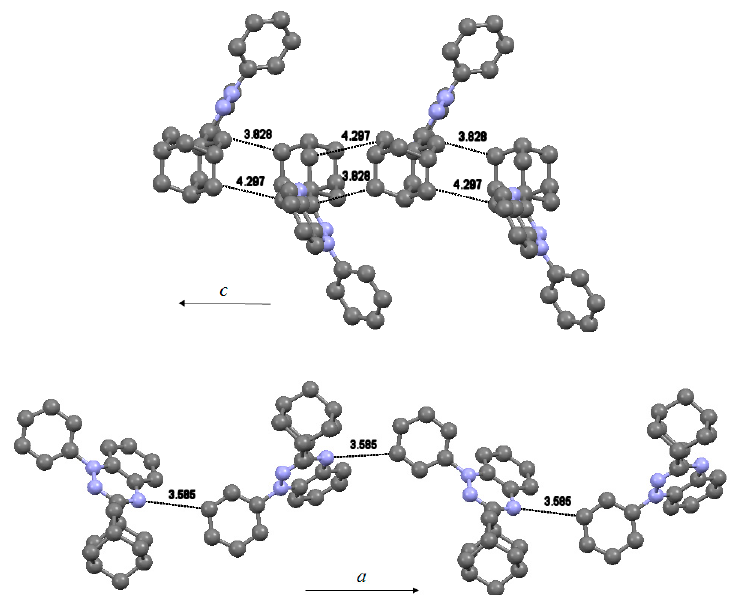
Figure 4. Solid-state packing of radical 4 demonstrating the formation of chains along c -axis ( top ) and along a -axis ( bottom ).